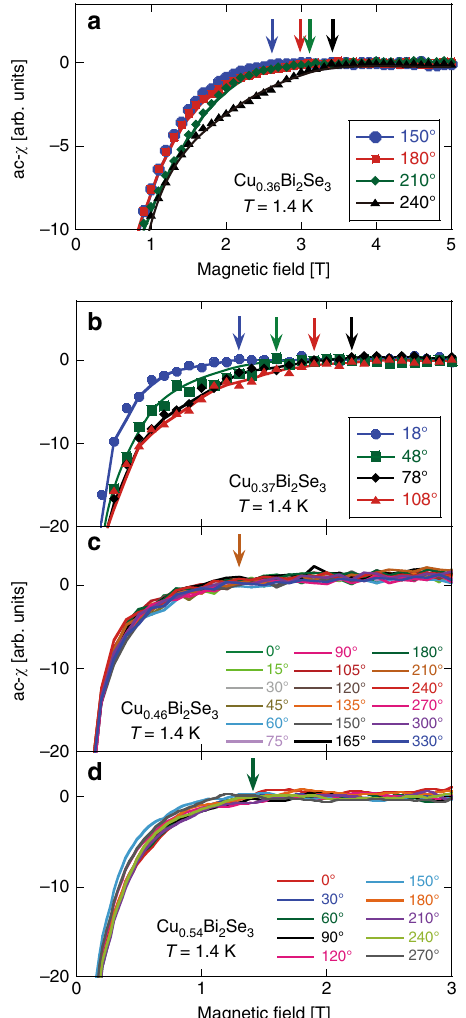
Fig. 7 Magnetic fi eld dependence of the ac- χ at different angle ϕ for x = 0.36, 0.37, 0.46, and 0.54. The solid curves are guides to the eyes. For sake of clarity, the data points for x = 0.46 and 0.54 are represented by symbols with minimized size. The arrows indicate H c2 de fi ned in the same way as previous fi gures. For x = 0.46 and 0.54, the arrow is for ϕ = 15 and 90°,